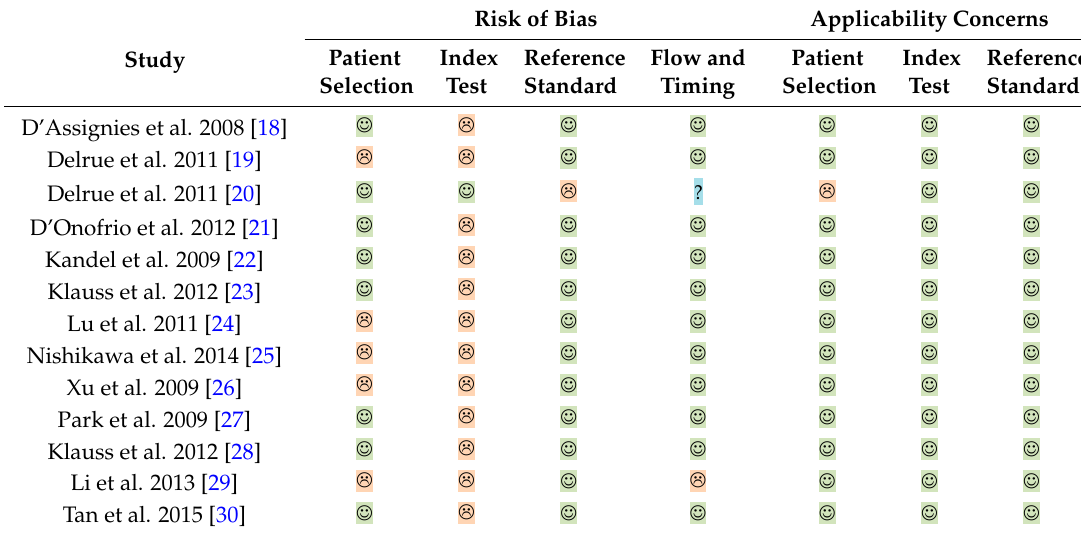
with anti-EGFR [30]. The same study showed that patients with a decrease in blood flow had a significantly longer median progression-free survival.